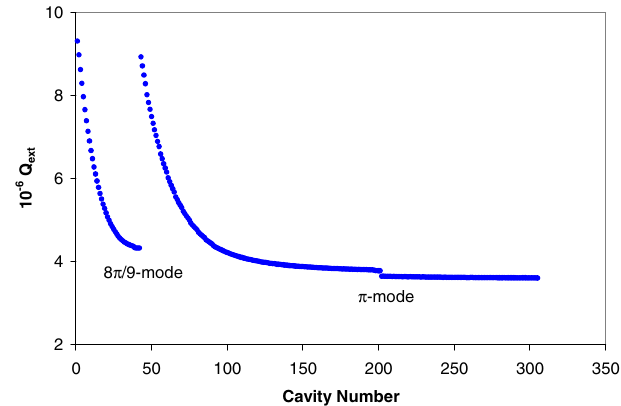
FIG. 5. (Color) Q as a function of cavity number in the high ext energy section of the modified